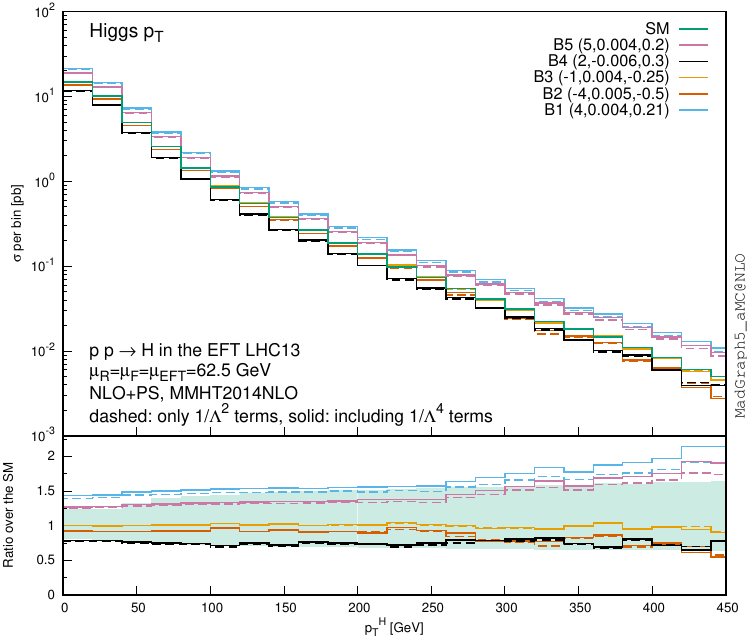
Figure 6 . Transverse momentum distributions of the Higgs for di(cid:11)erent values of the Wilson coe(cid:14)cients. The lower panel shows the ratio over the SM prediction for the various benchmarks and the SM scale variation